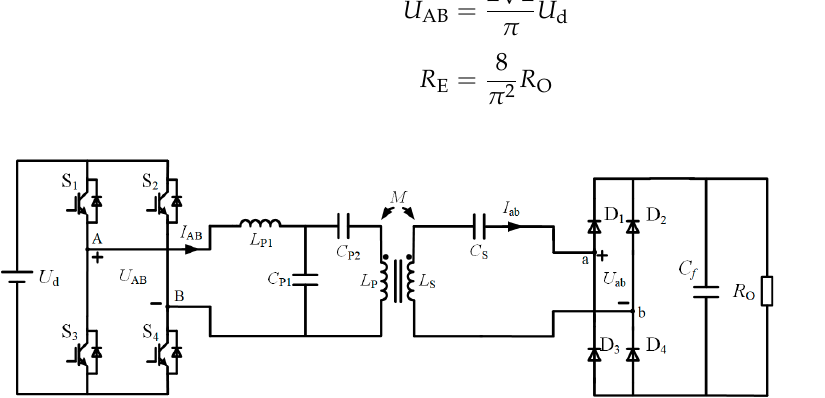
Figure 1. Analysis models of the loosely coupled transformer: ( a ) t he mutual inductance model; ( b ) the transformer model.